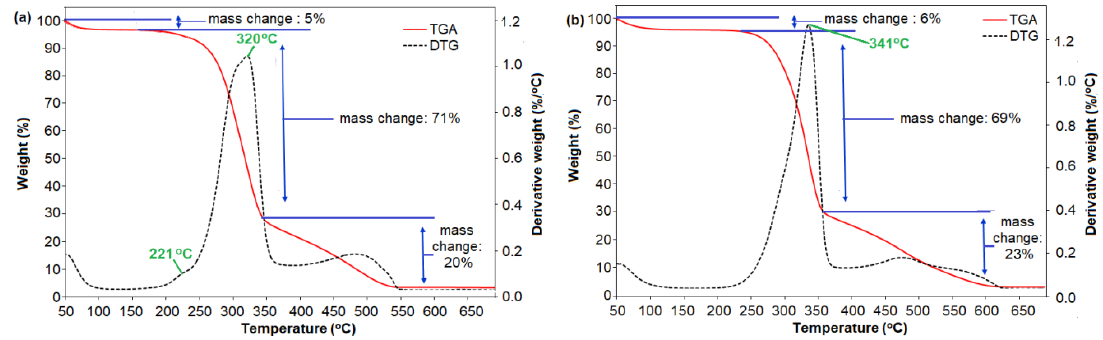
Figure 5. TGA and DTG curves of ( a ) untreated C. pentandra fiber and ( b ) treated C. pentandra fiber.